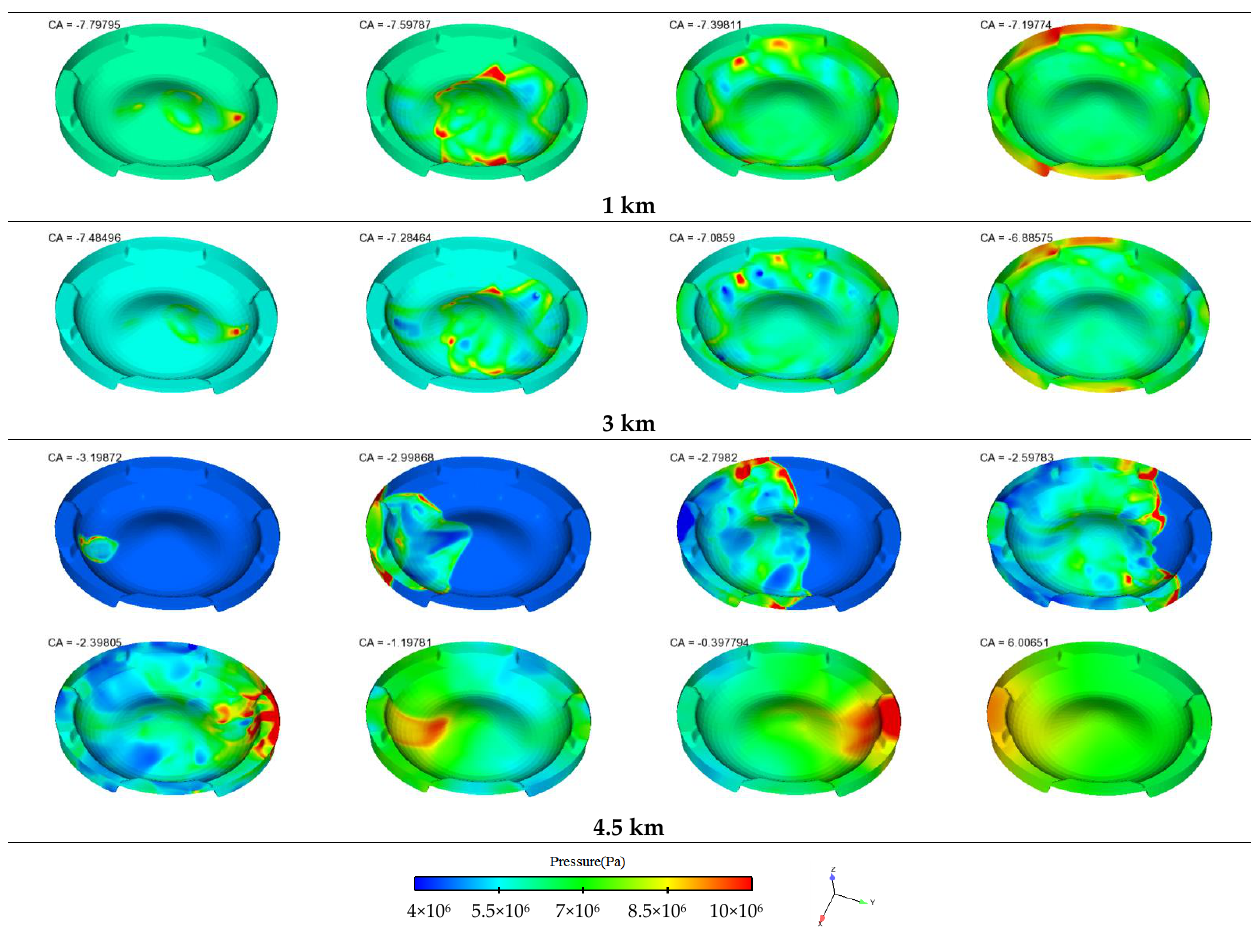
Figure 12. Comparison of pressure distribution at various